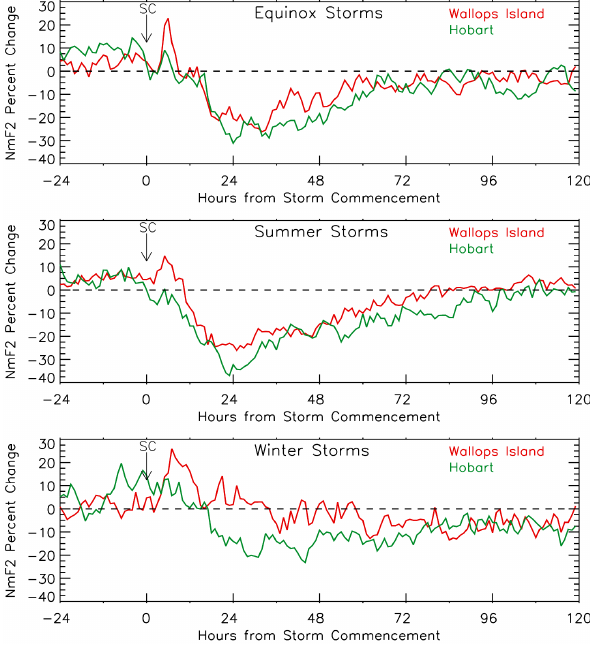
Fig. 6. Average storm-time patterns for Wallops Island and Hobart sorted by season. See Table 2 (or text) for the number of events in each